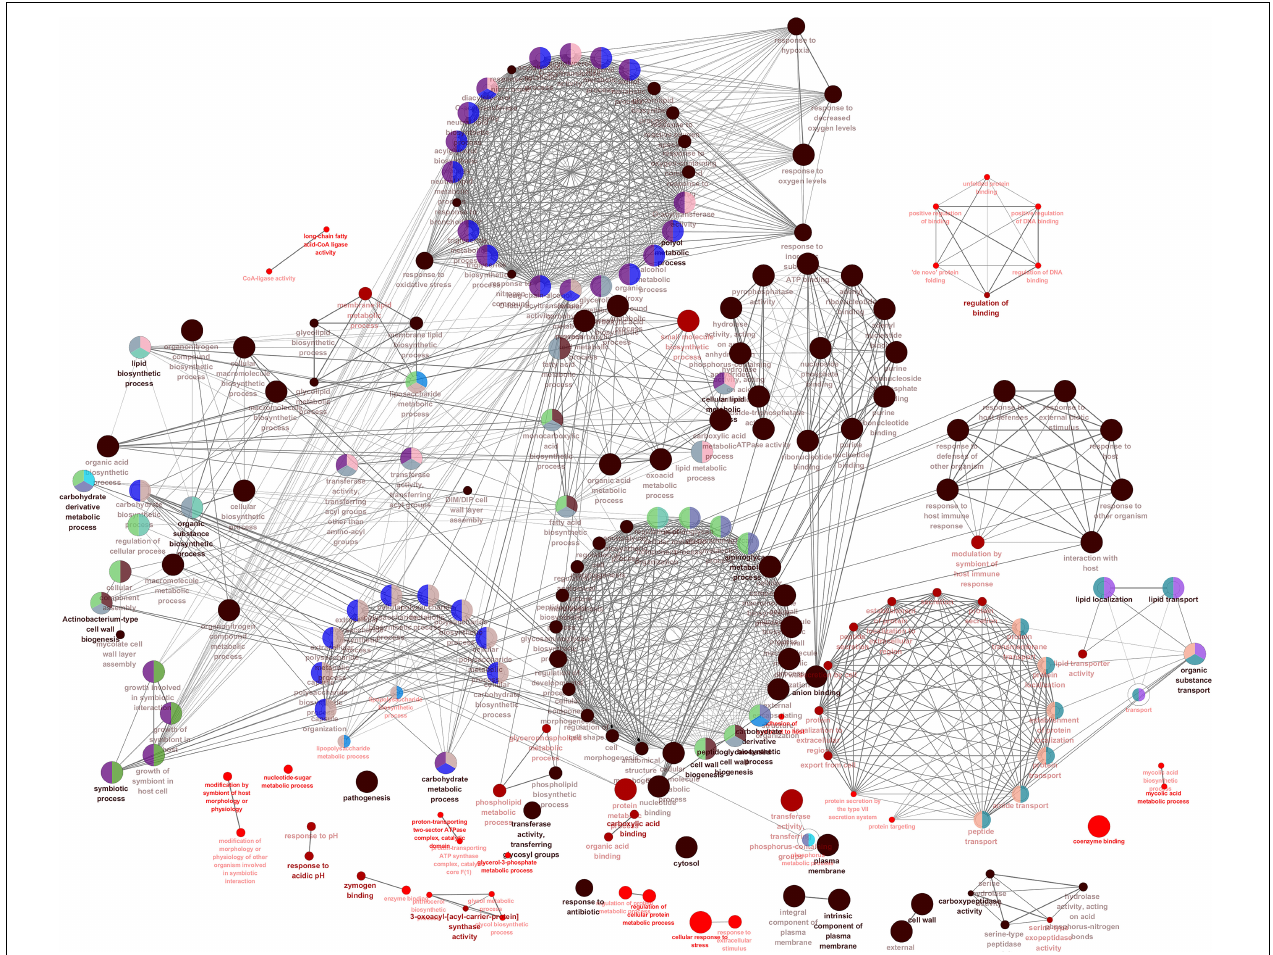
FIGURE 3 | The enrichment map of GO annotation and KEGG pathway. Node size represents the number of cell wall genes expressed in specific terms. The edge thickness represents the number of genes shared by the two items connected by the edge.